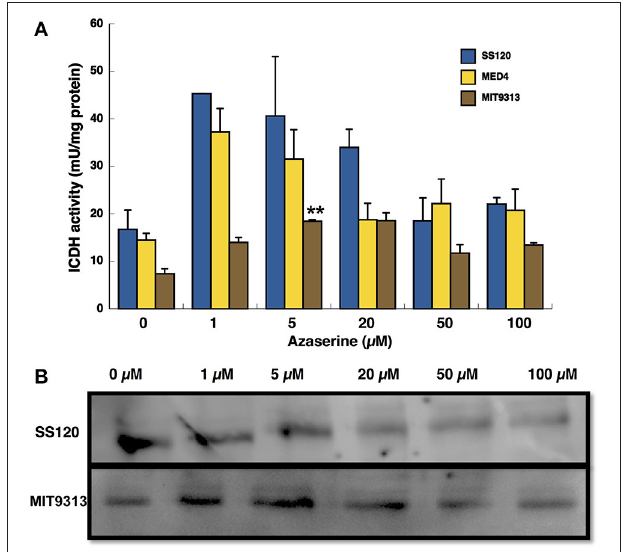
FIGURE 2 | Effect of different concentration of azaserine on ICDH activity (A) and ICDH protein concentration (B) in different strains of Prochlorococcus. The different concentrations of azaserine were added to the cultures and cells were collected after 24h of treatment. (A) is a representation of three independent biological replicates of each strain. Error bars correspond to standard deviation. (B) corresponds to a Western blotting using anti-ICDH